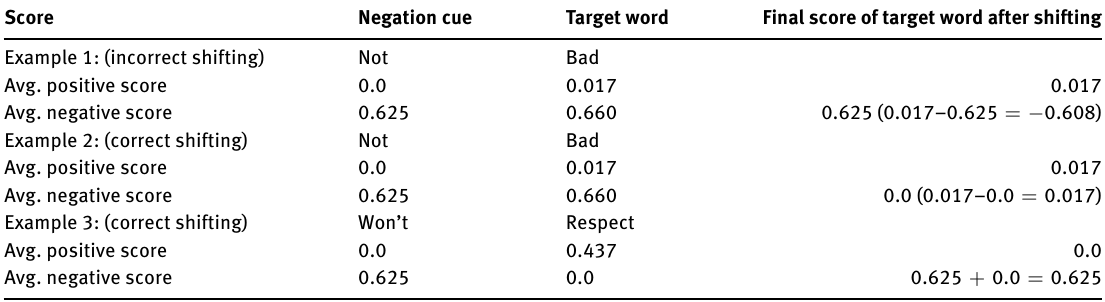
Table 2: Negation Adjustment